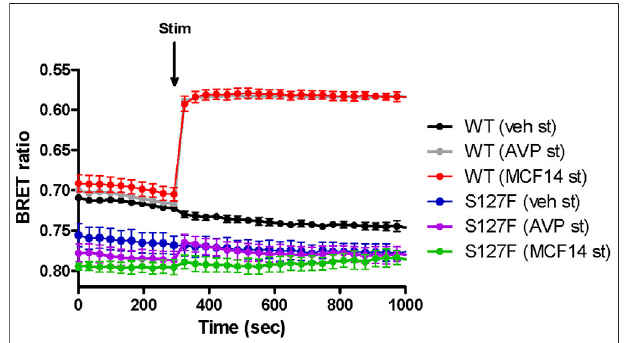
FIGURE4| EffectofacuteMCF14stimulationonthecAMPlevelofwild- type or S127F mutant V2 receptor-expressing cells. HEK293 cells were transiently transfected for 24 h with the plasmids of the Epac-BRET sensor and either WT-V2R or S127F-V2R. The cells were exposed to vehicle or 1 µM AVP or 10 µM MCF14 at the indicated time point. The BRET curves are an average of three independent experiments, each performed in triplicates. Mean values ±S.E. are shown ( n = 3). Since increasing cAMP decreases the BRET ratio, the y axis was inverted to visually represent cAMP level